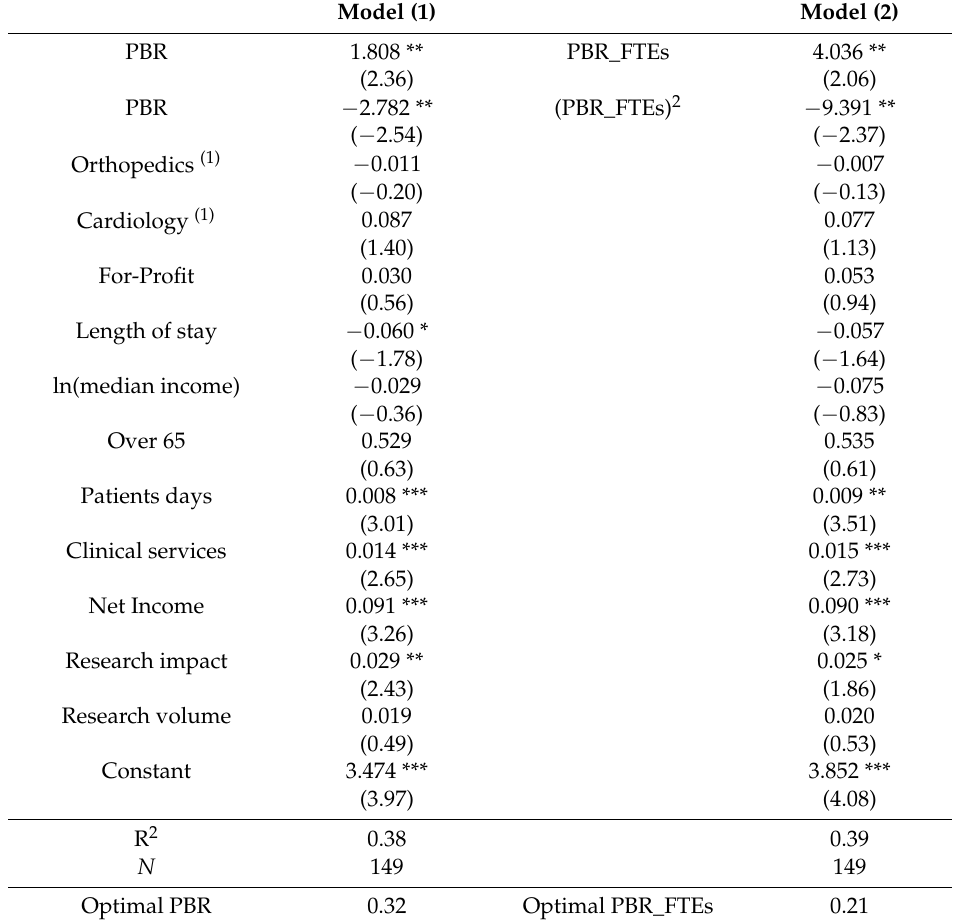
Table 4. IV-GMM–regression. Dependent variable: Ln( IHQ ), endogenous variable: